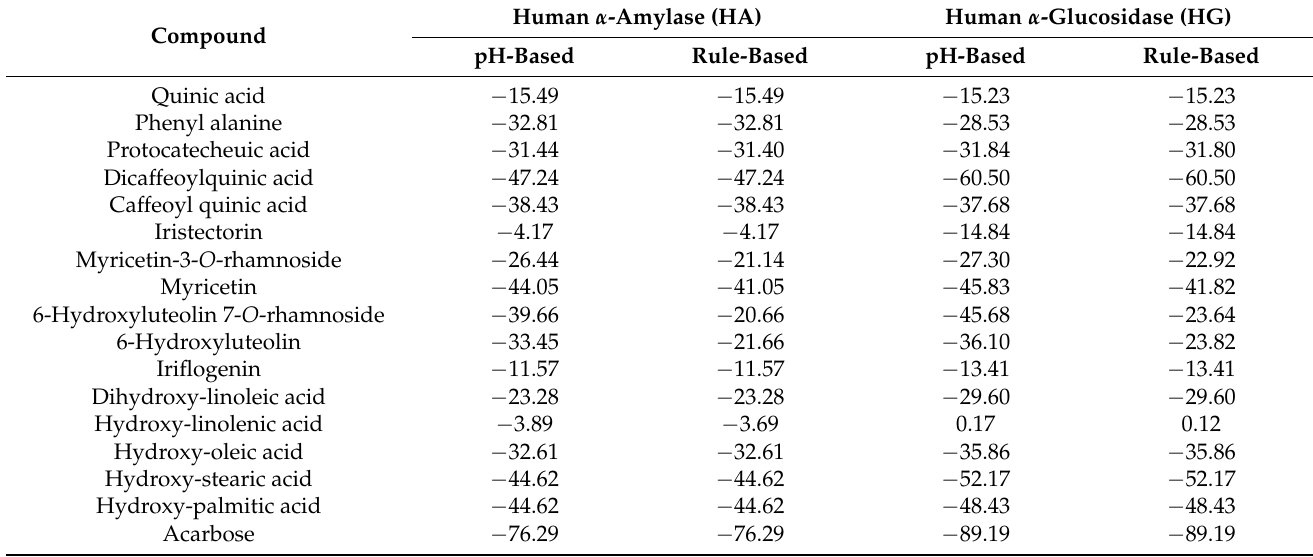
Table 6. Free binding energies ( ∆ G) of the major identified compounds with human α -amylase (HA) and human α - glucosidase (HG) enzymes active centers using molecular docking with pH- and rule-based methods and expressed in